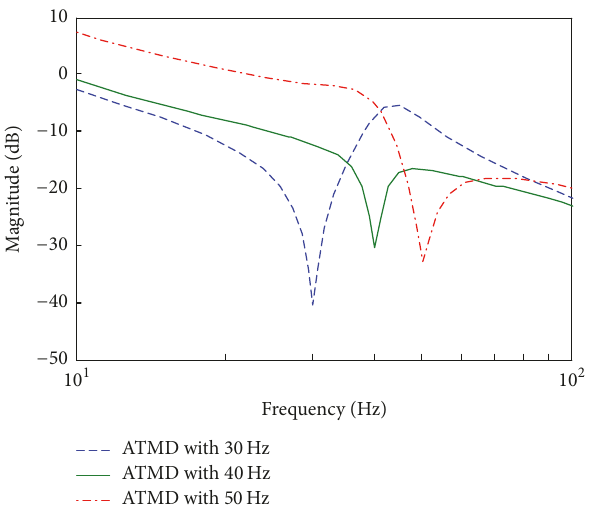
Figure 6: Required active force of ATMDs with different natural frequencies.